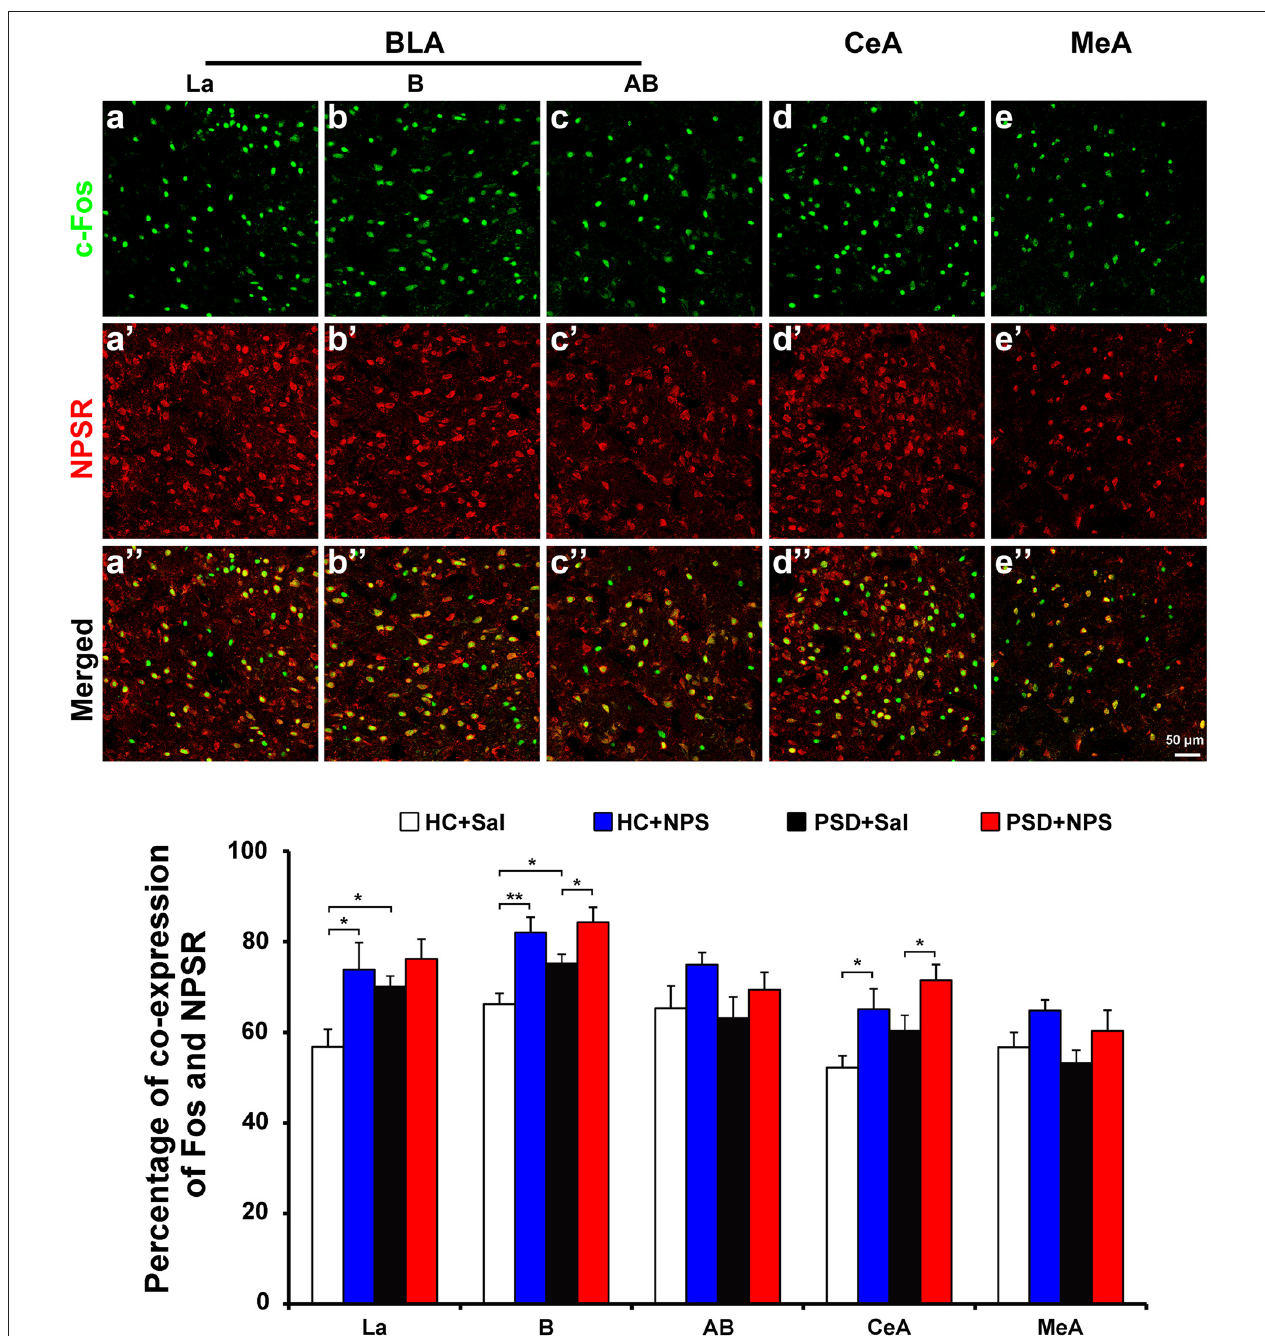
FIGURE 8 | Distribution of Fos-ir neurons expressing NPSR in the amygdala. Photomicrographs representatively show Fos-ir neurons (green) in the BLA including La (a) , B (b) and AB (c) , the CeA (d) and MeA (e) after the HC rats given NPS, NPSR-ir neurons (red) in the La (a’) , B (b’) , AB (c’) , CeA (d’) and MeA (e’) , and the co-expression (yellow) of Fos-ir and NPSR-ir neurons in the La (a”) , B (b”) , AB (c”) , CeA (d”) and MeA (e”) , respectively. Bar = 50 µ m. The histogram displays the percentage of Fos-ir neurons expressing NPSR in the amygdala (bottom panel) in HC and PSD rats given saline or NPS. Values are means ± SEM. ∗ P < 0.05, ∗∗ P < 0.01. Data were analyzed by two-way ANOVA. Abbreviations: AB, accessory basal nuclei; B, basal nuclei; BLA, basolateral amygdala; CeA, central amygdala; La, lateral nuclei; MeA, medial amygdala.